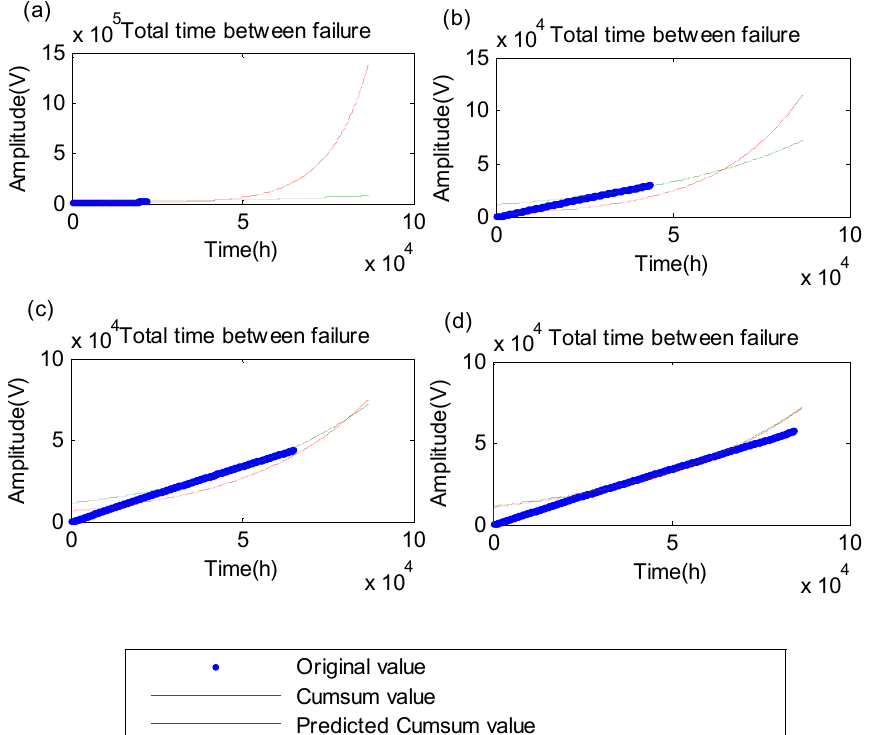
Figure 12. The RUL prognostics results with the energy of the accumulative signal utilizing the proposed method: ( a ) prognostics result based on 25% of the accumulative data; ( b ) prognostics result based on 50% of the accumulative data; ( c ) prognostics result based on 75% of the accumulative data; ( d ) prognostics result based on 100% of the accumulative data.